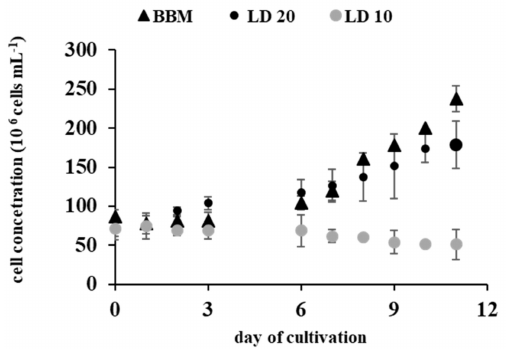
Figure 1. Growth curve of A. protothecoides (the results are presented as means of 9 measurements from n = 3; error bars represent standard deviation), the black triangles represent the number of cells in the control BBM medium; circles: the black circles represent the number of cells in the 1:20 liquid digestate (LD 20) and the grey circles represent the number of cells in the 1:10 liquid digestate (LD